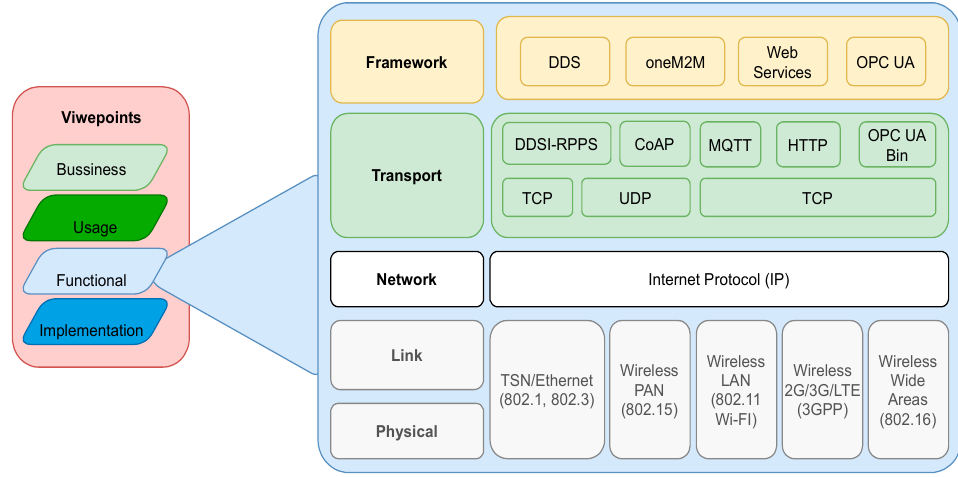
Figure 1. IIRA viewpoints and communication layer of IICF [18].